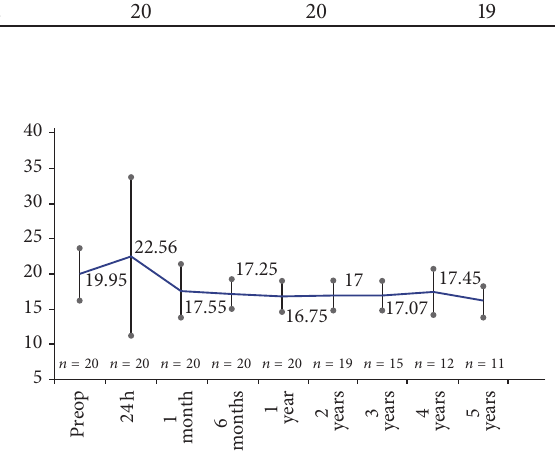
Figure 1: Mean intraocular pressure (IOP) ( ± standard error of the mean) recorded at each follow-up visit (baseline IOP is medicated IOP).